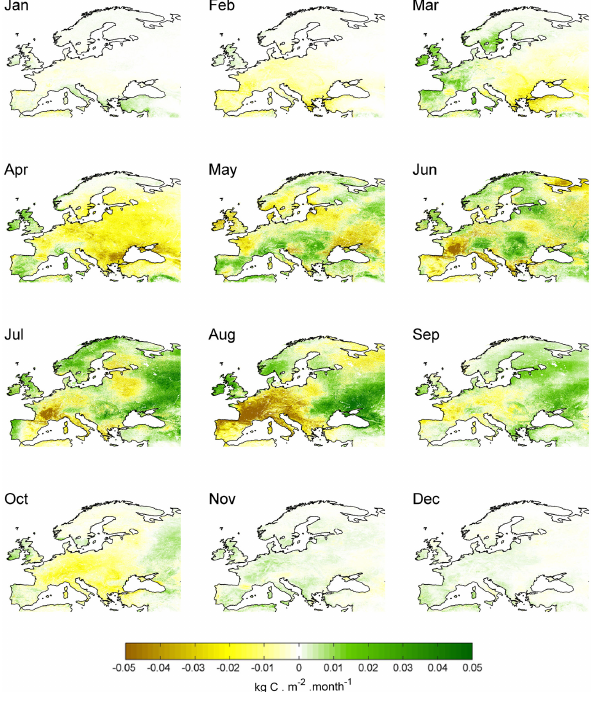
Figure 6. As in Fig. 5, but for 2010.